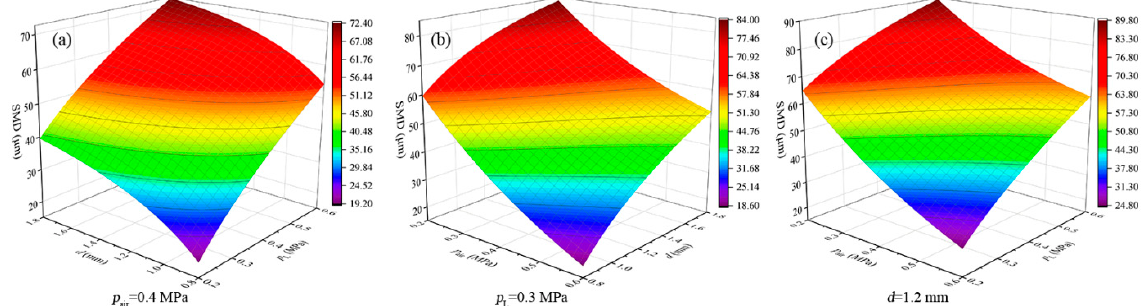
Figure 8. The relationship between the SMD of a single-factor constant nozzle and various factors: ( a ) p air = 0.4 MPa; ( b ) p L = 0.3 MPa; and ( c ) d = 1.2 mm.